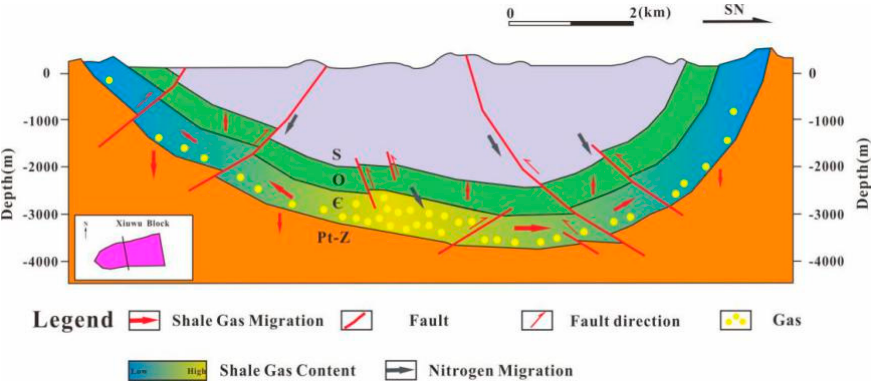
Figure 8. Seismic interpretation results for the Xiuwu Basin.